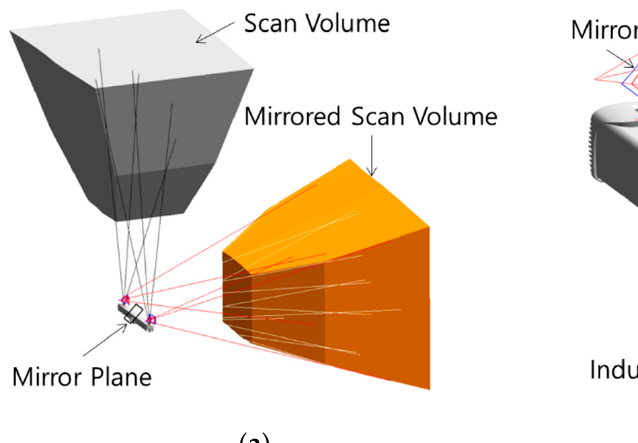
Figure 3. Optical Path Configuration: ( a ) Scan Volume; ( b ) Boundaries of Mirror and Window.